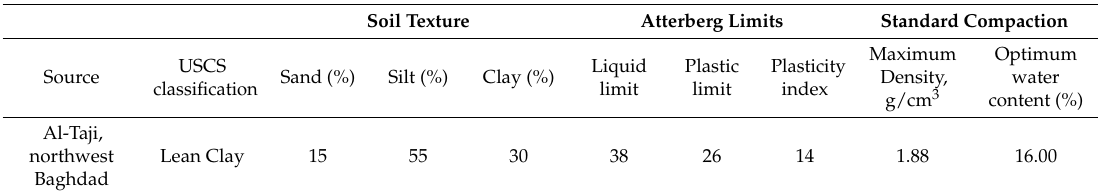
Table 2. Physical characteristics of soils used for the JETs.